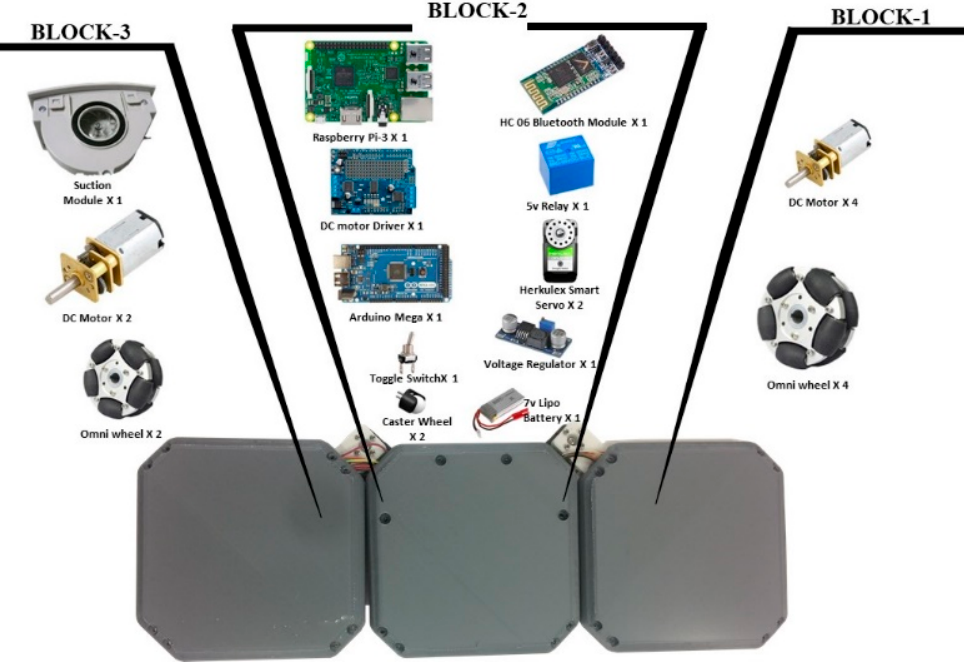
Figure 11. Components list of hTromo robot.